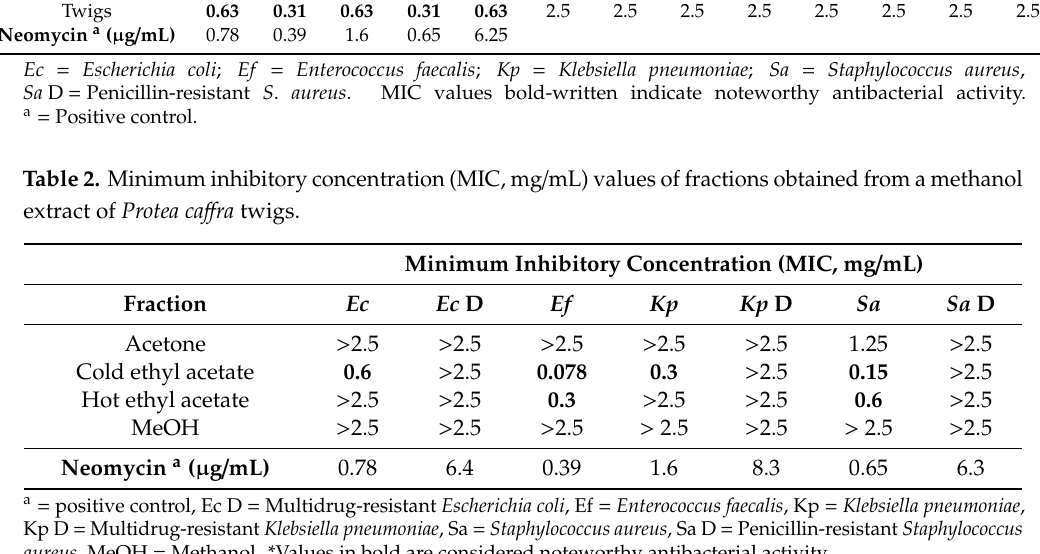
Table 1. Minimum inhibitory concentration values (MIC, mg / mL) of Protea ca ff ra extracts screened against drug-sensitive and -resistant bacterial strains. Minimum Inhibitory Concentration (MIC, mg / mL) Methanol Dichloromethane Petroleum Ether Plant Part Bark